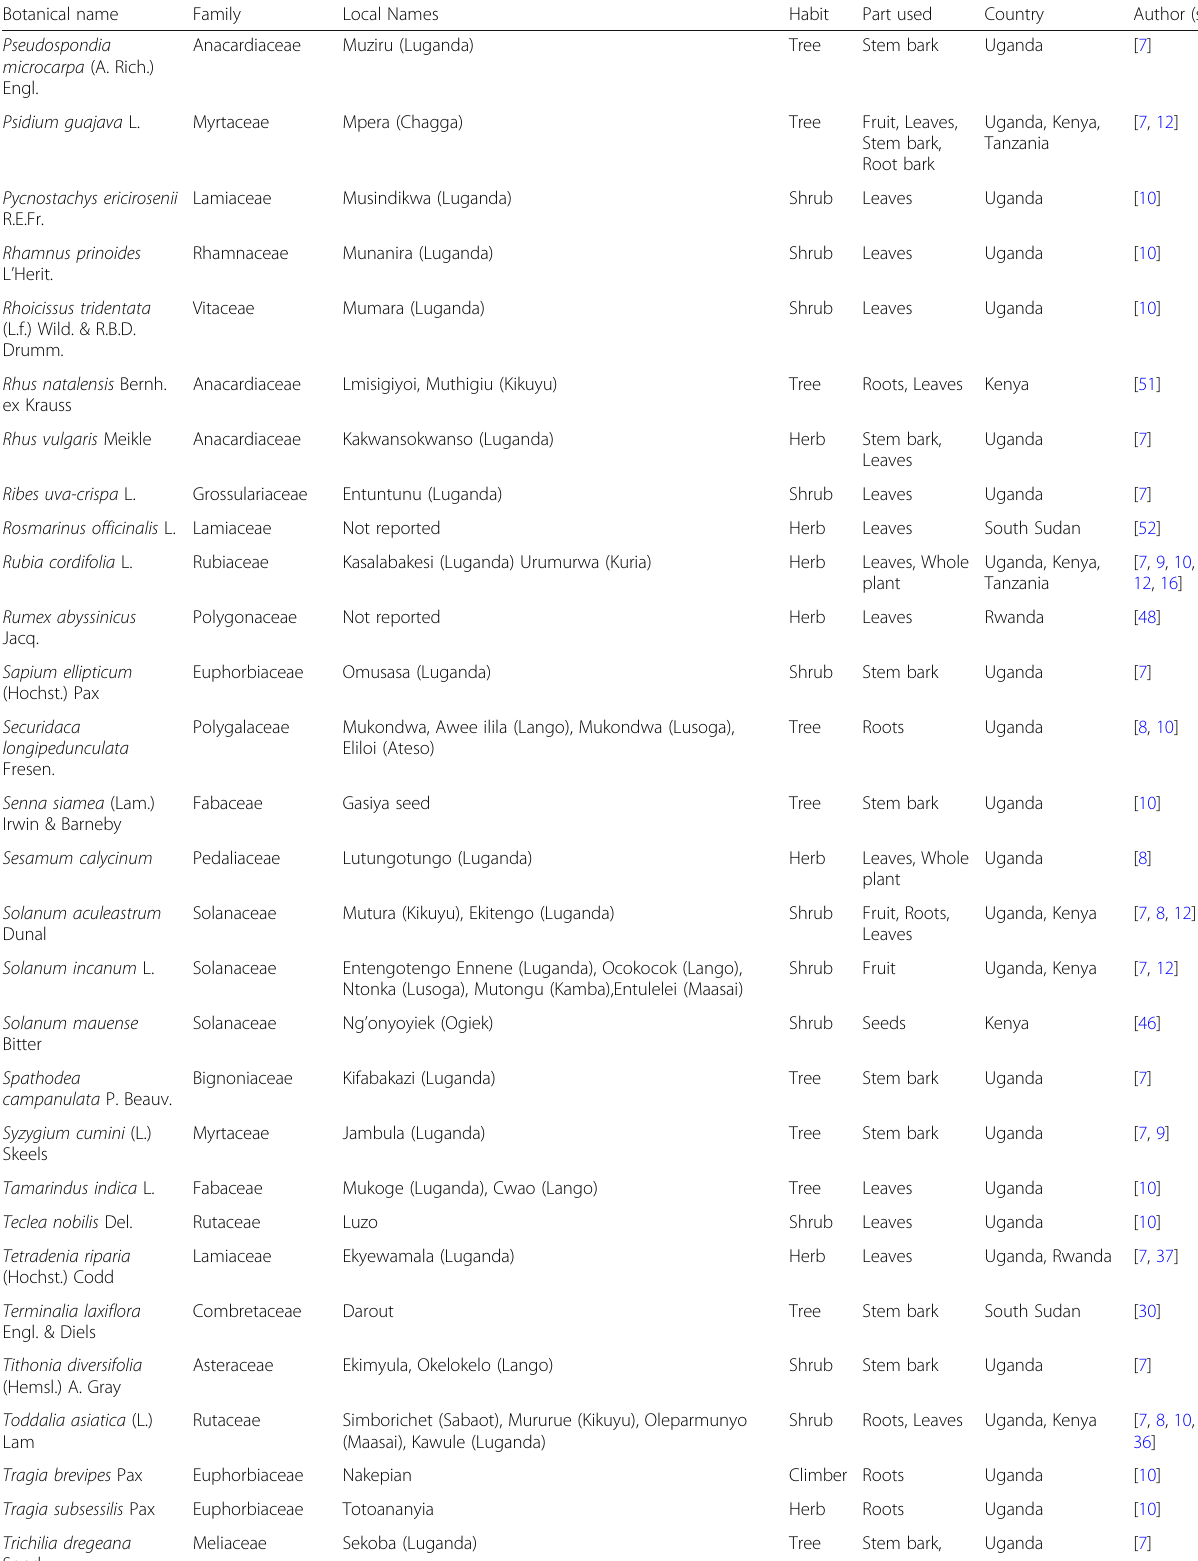
Table 1 Medicinal plants used in treatment of symptoms of TB in East Africa (Continued) Botanical